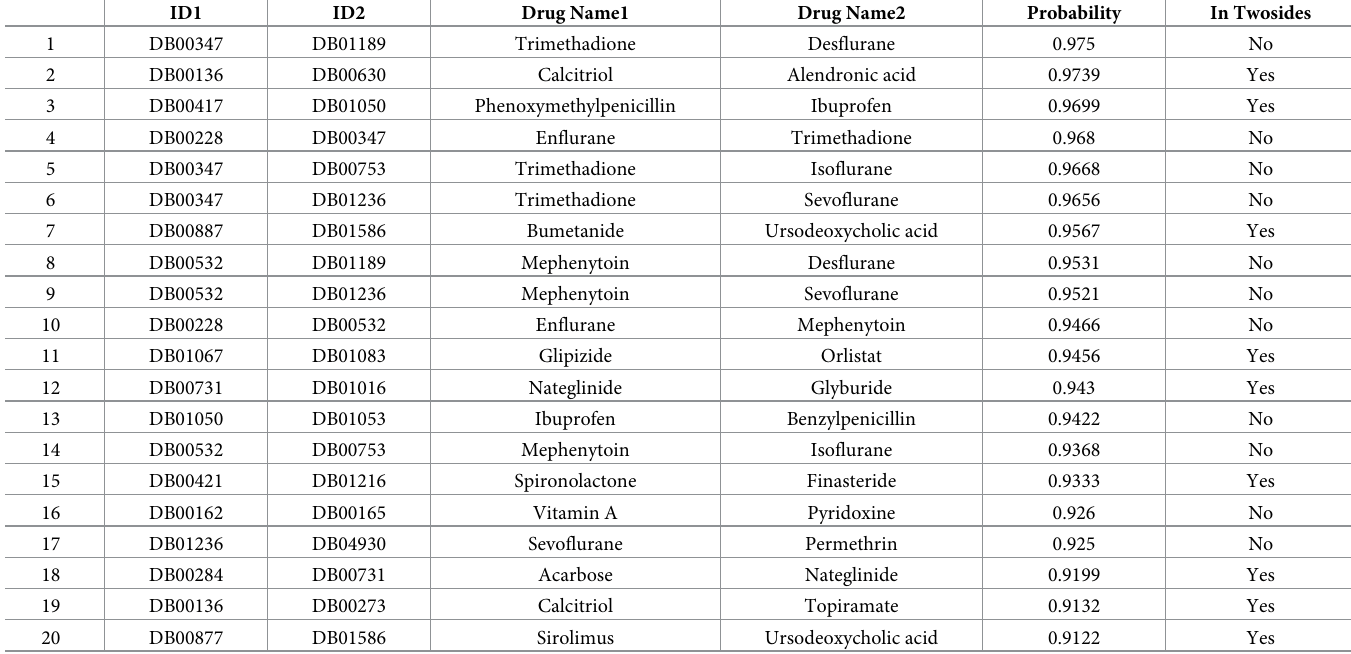
Table 2. Top 20 new adverse DDI